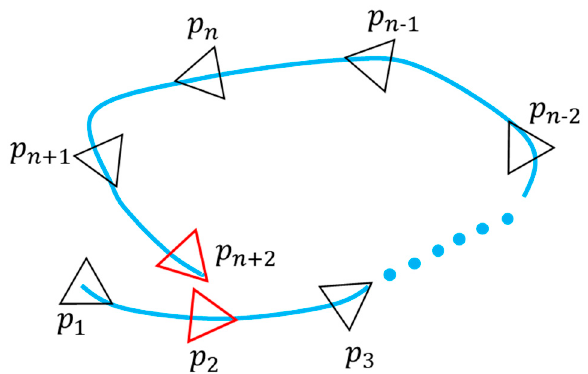
Figure 4. Schematic diagram of loop detection.